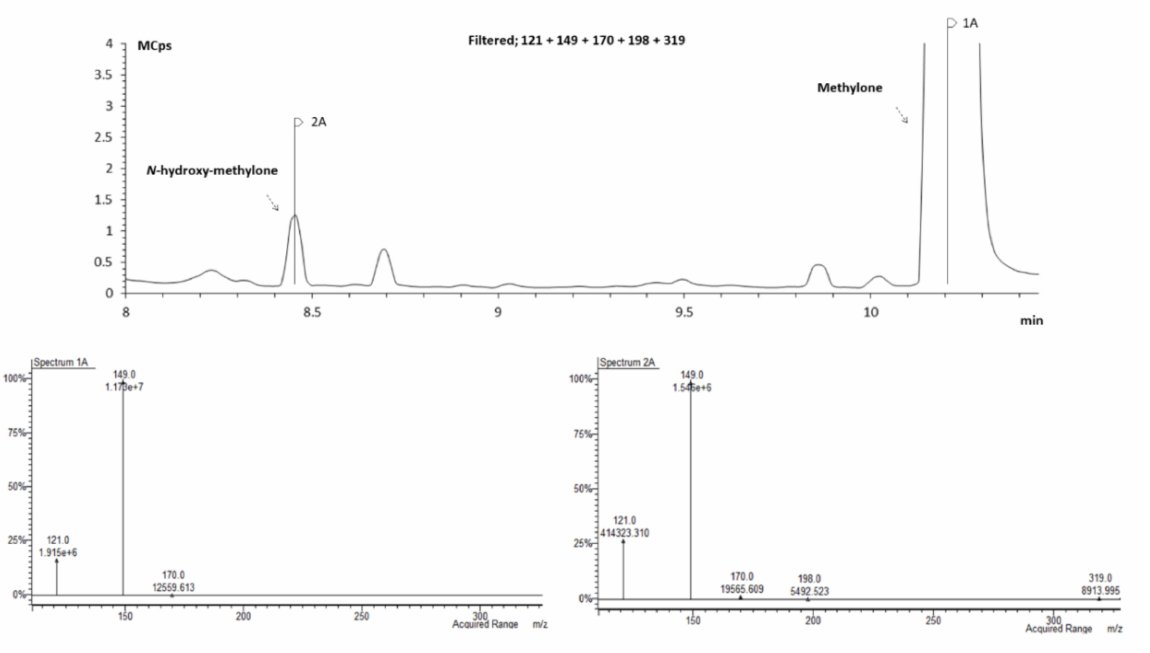
Figure 7. Zoomed GC–MS SIM mode chromatogram of an extracted sample of HLM incubated with S -( − )-methylone for 30